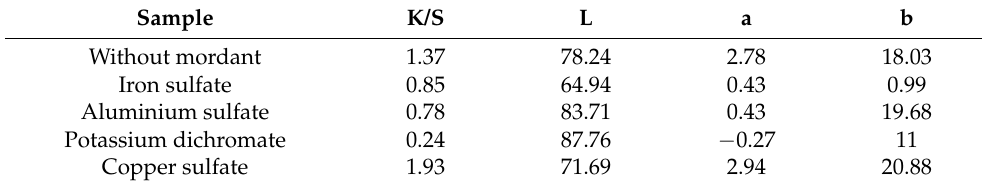
Table 3. Colorimetric data of cotton